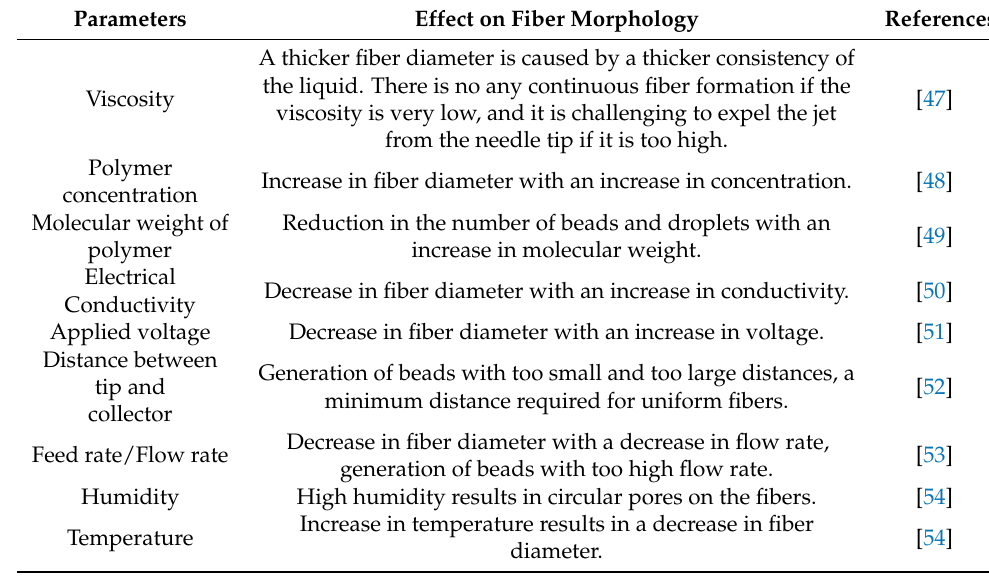
Table 1. Effects of main electrospinning factors (solution, processing and ambient) on fiber morphology.